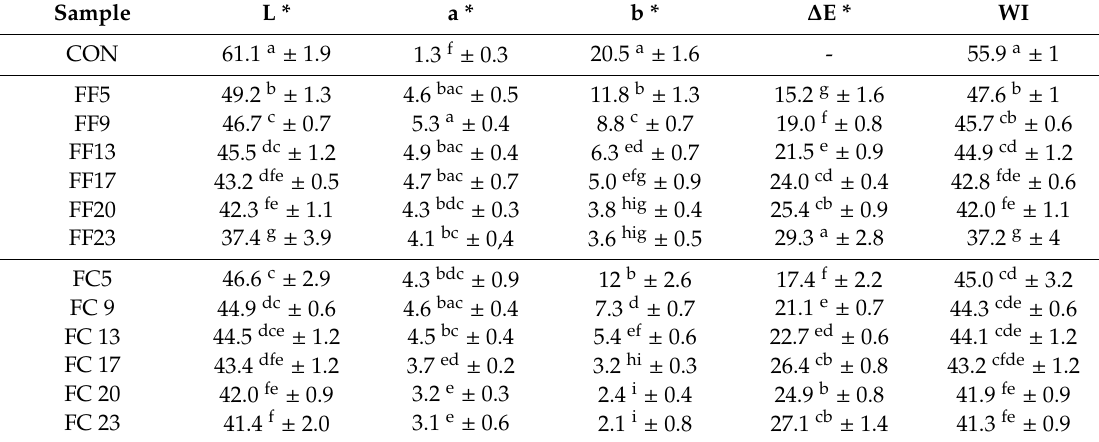
Table 2. Variation of color parameters of cooked pasta with flaxseed flour (FF) and flaxseed cake (FC).